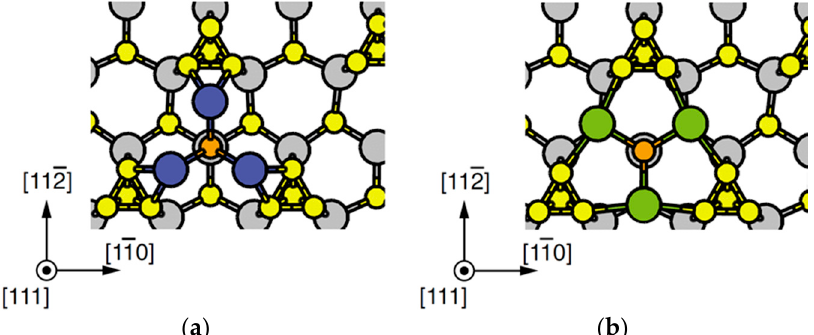
Figure 17. Top views of ( a ) 3In-P occupying the ZB lattice sites (3In-ZB-P) and ( b ) 3In-P occupying the WZ lattice sites (3In-WZ-P) on the InP(111)A surface. Large and small circles represent In and P atoms, respectively. Blue and green circles denote the In adatoms that occupy the lattice sites of the ZB and WZ structures, respectively. Orange circles represent the P adatoms. Reprinted with permission from [95]. Copyright (2011) by the Japan Society of Applied Physics.